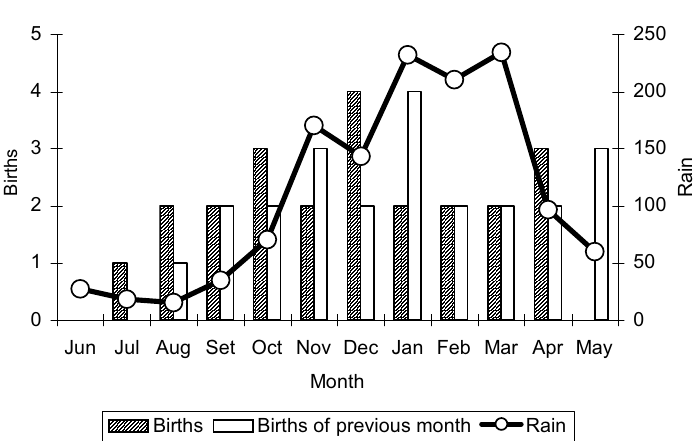
Fig. 1 – Monthly precipitation compared with births in the previous month of M. gouazoubira in the Horco Molle Experimental Reserve-REHM from